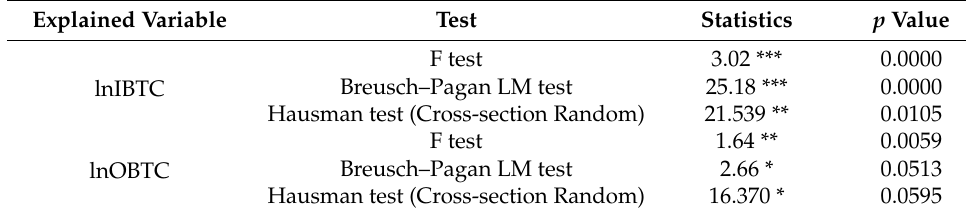
Table 10. Summary of F test, Breusch–Pagan LM test, and Hausman test results. Explained